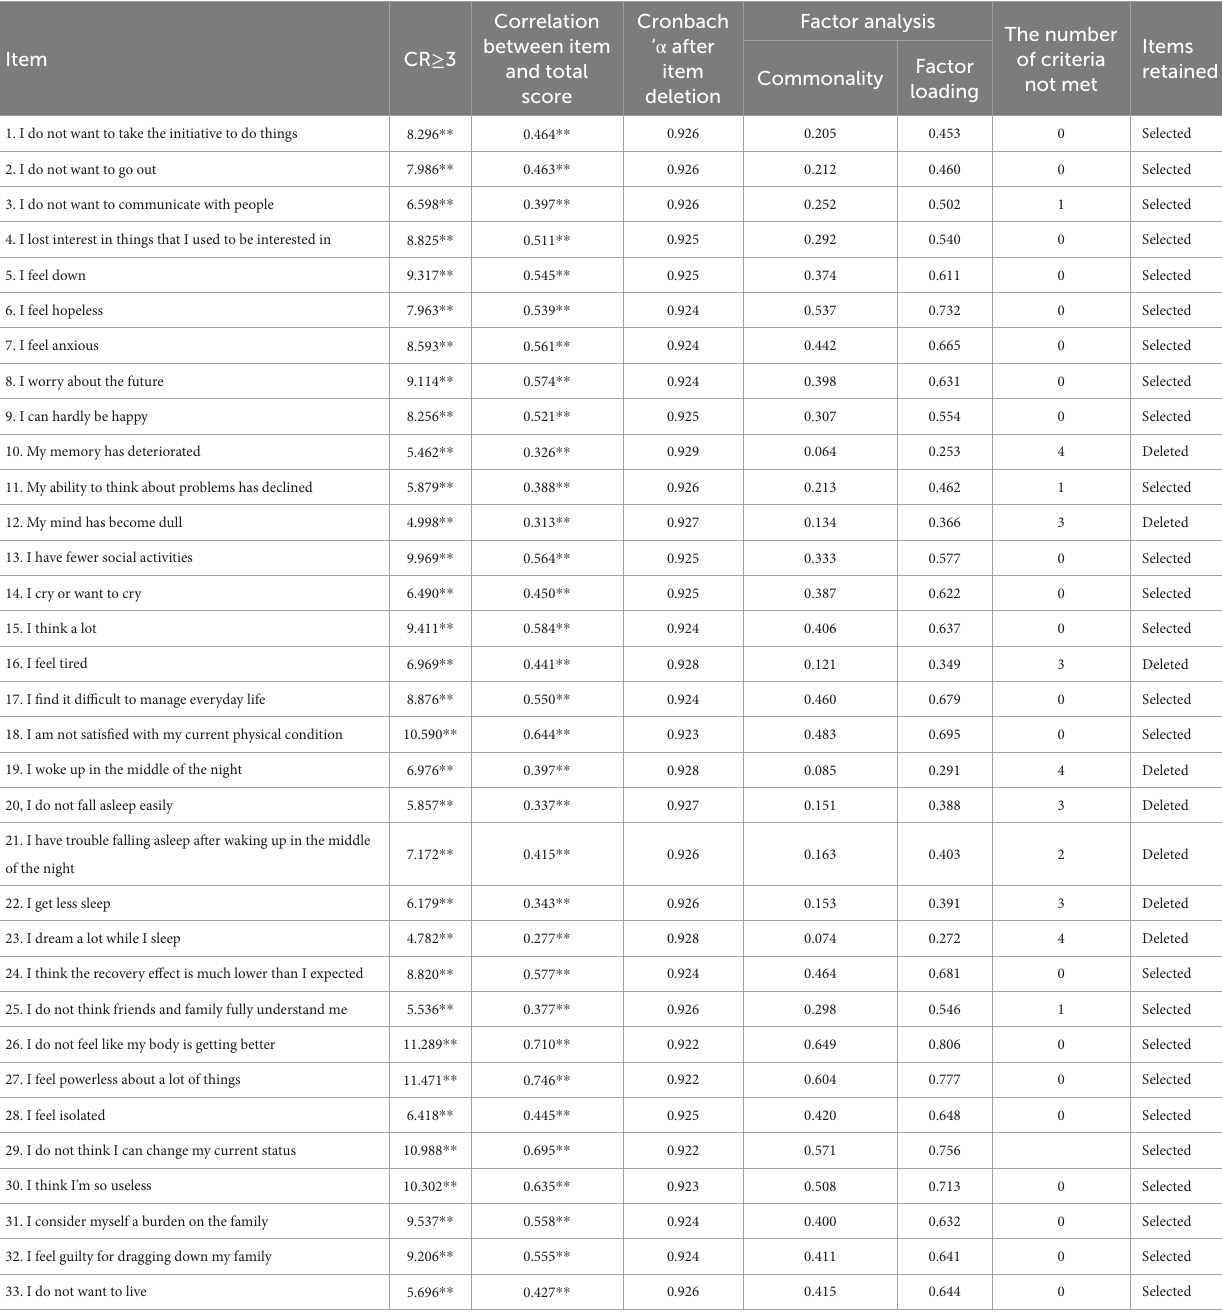
TABLE 2 The result of item analysis ( N = 356).